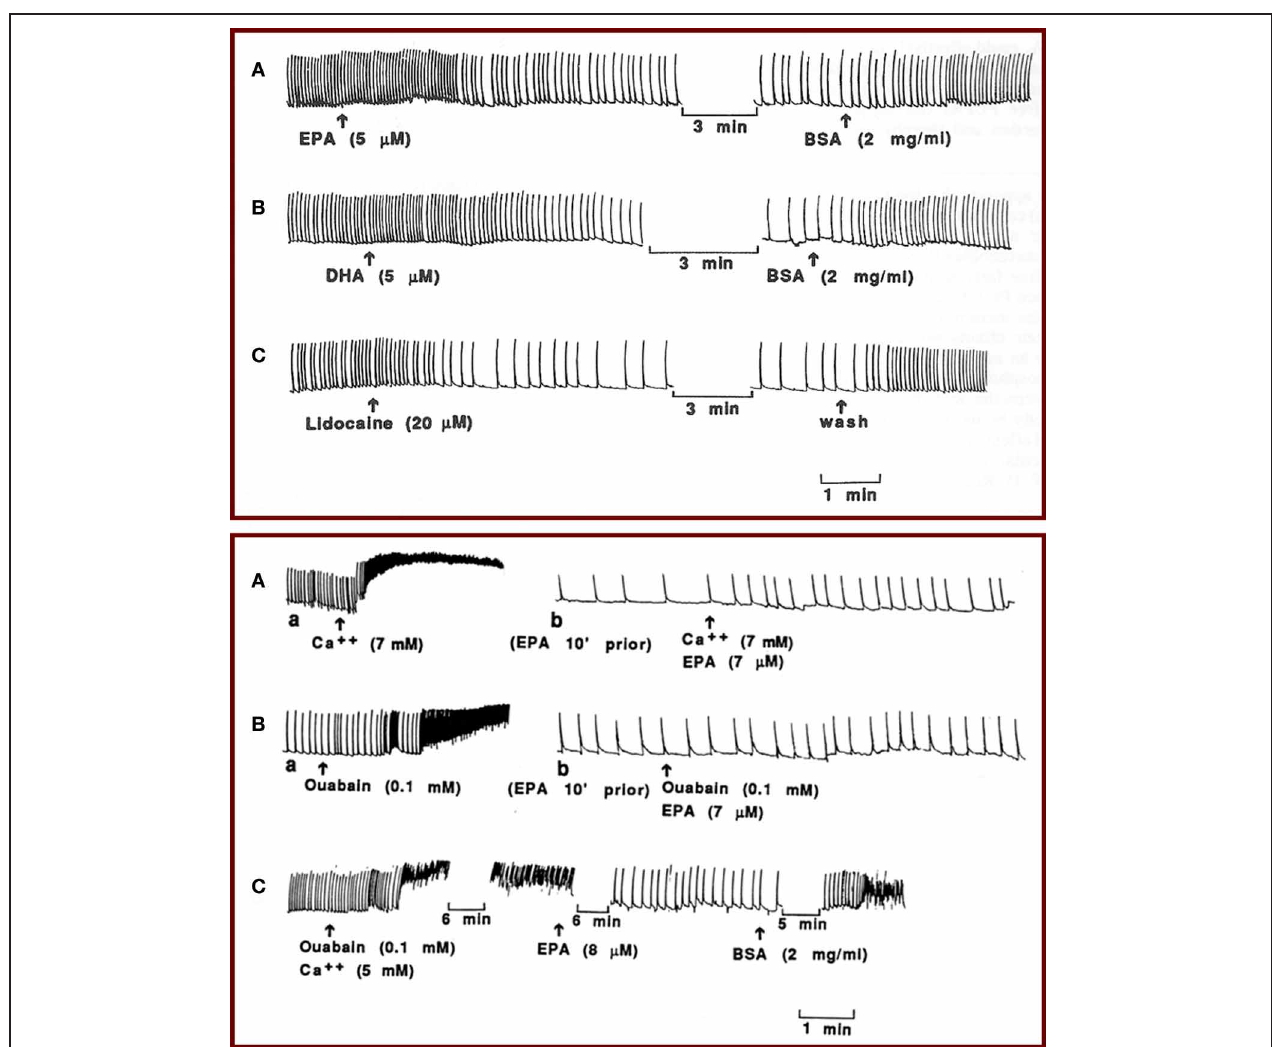
fibrillations to the original beating rate (not shown). Then the cells were perfused with medium containing 7 µ M EPA. After 5–8min, when the beating rate was slowed, addition of 7mM Ca 2 + ( A , b) or 0.1mM ouabain ( B , b) failed to induce contracture or fibrillation in the same cells. The slow beating rates were subsequently returned to the original rates by perfusion with BSA (not shown). (C) Alternatively, after induction of fibrillation by ouabain (0.1mM) plus Ca 2 + (5mM), addition of IEPA (8 µ M) terminated the fibrillation and led to slow beating, and subsequent addition of BSA (2mg/ml), still in the presence of ouabain and high external Ca 2 + concentration, reinstated